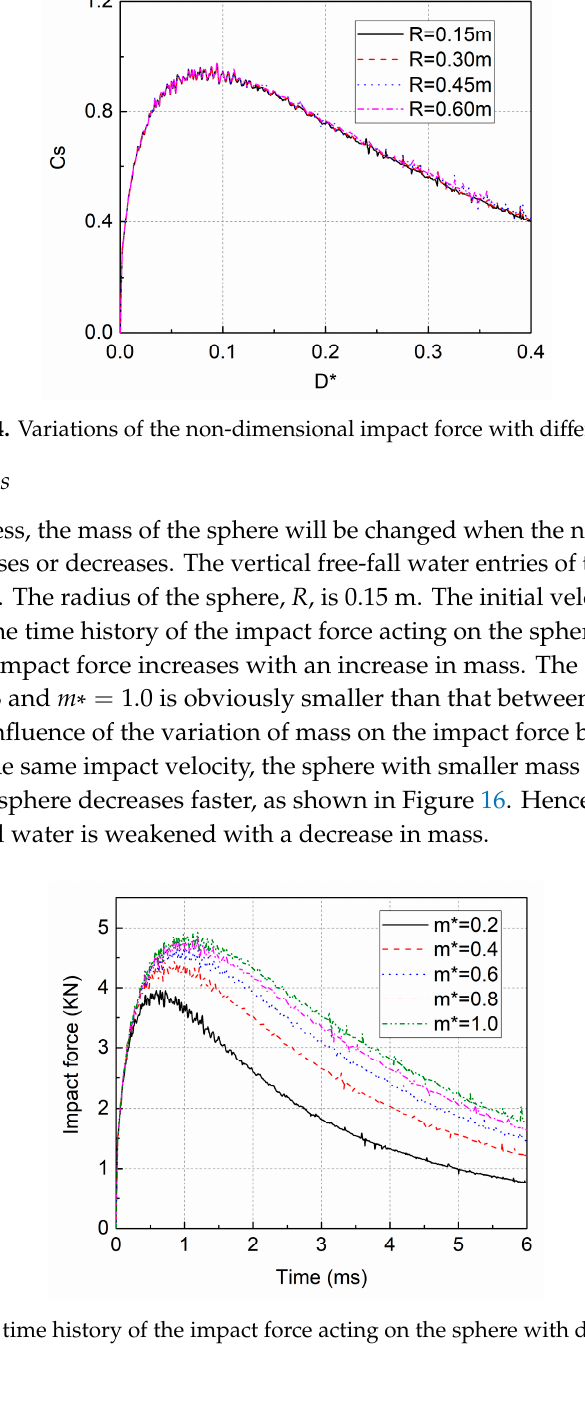
Figure 15. The time history of the impact force acting on the sphere with different masses.